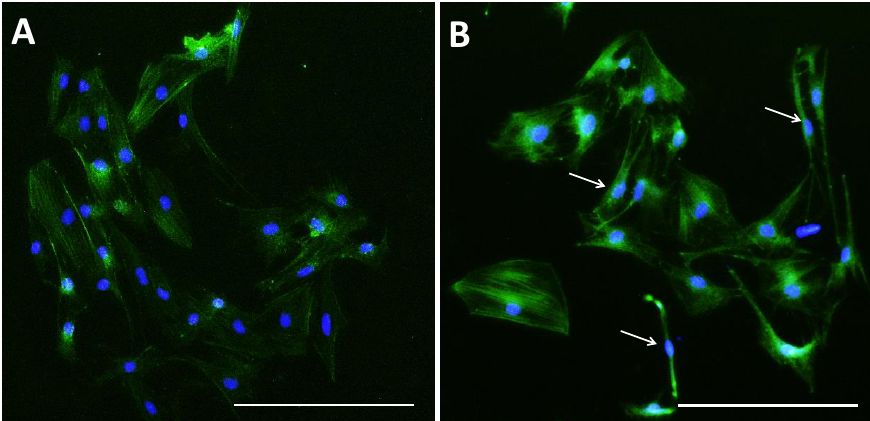
Figure 5. Microfilament distribution in pGCs. pGCs from the control group showed the parallel distribution of microfilament bundles ( A ); while the distribution of microfilament bundles varies with the morphology of pGCs under SMG (white arrows indicate microfilament distribution in pGCs with different shapes) ( B ). Scale bar = 223.64 µ